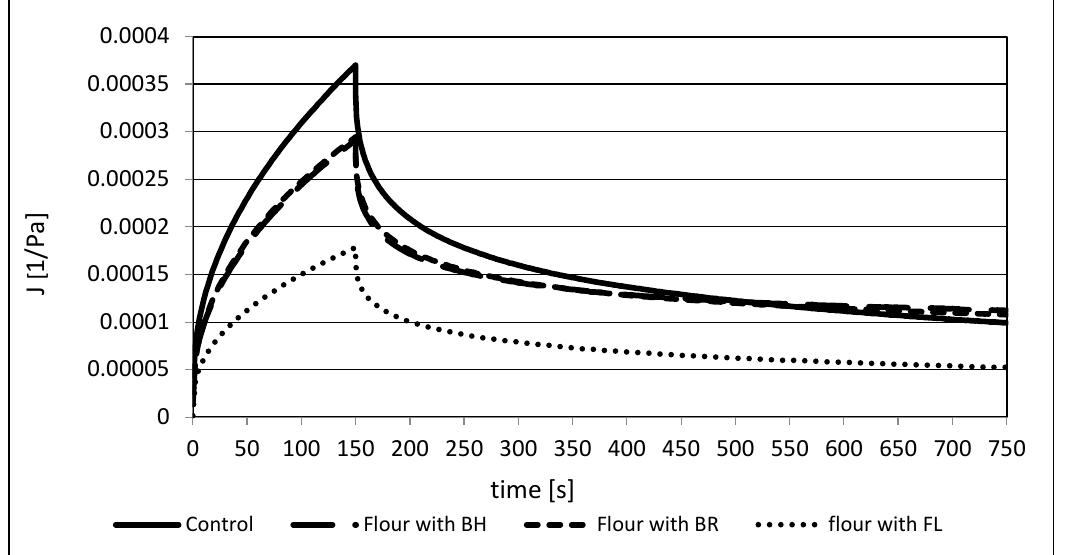
Figure 2. Creep and recovery curves of tested doughs.